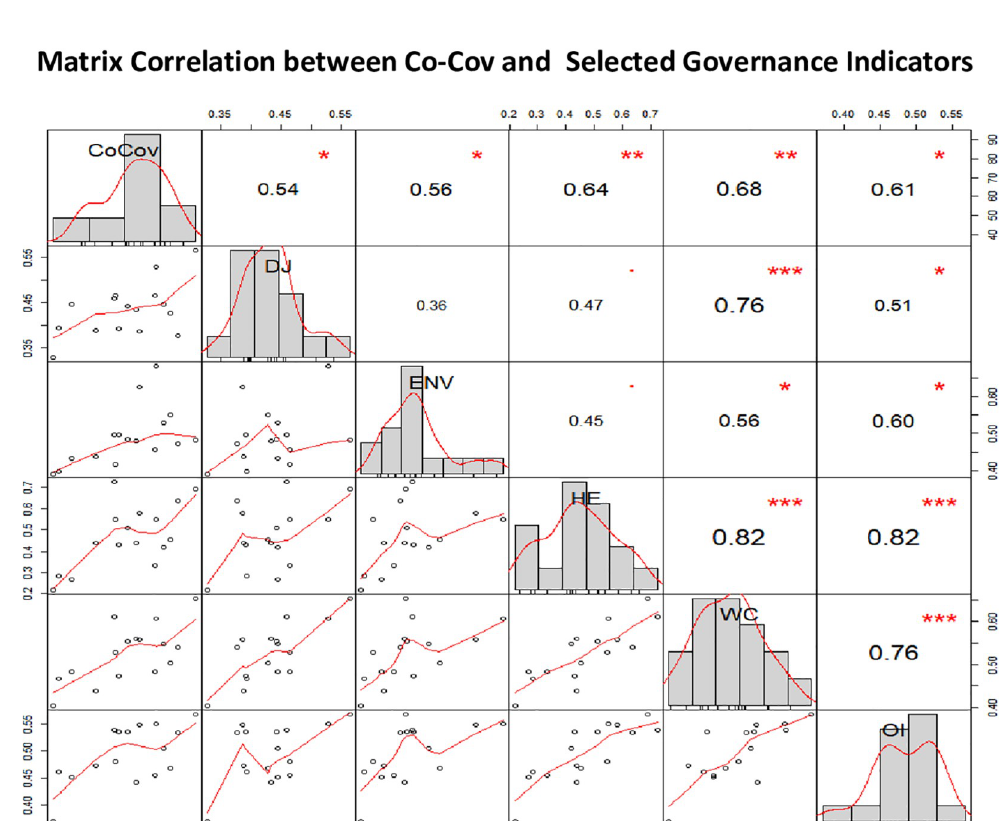
Fig 3. https://doi.org/10.1371/journal.pone.0258244.g003 PLOS ONE | https://doi.org/10.1371/journal.pone.0258244 November12,